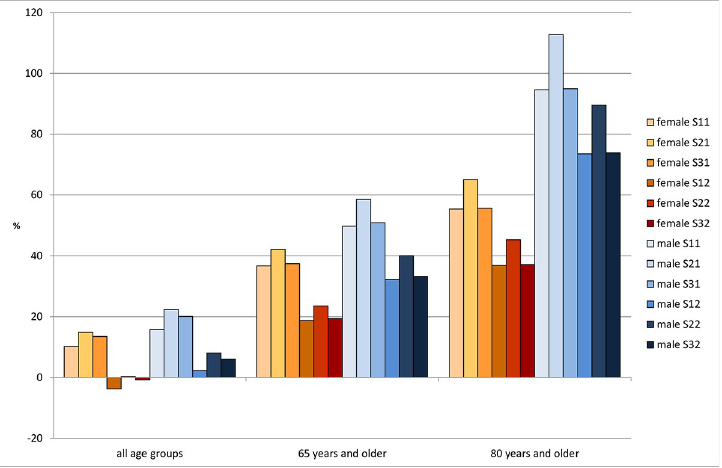
Fig 6. Change in the total number of treatment days, in the age group 65 years of age or older and 80 years of age or older. Source: Population projection 2016–2040 [21], own